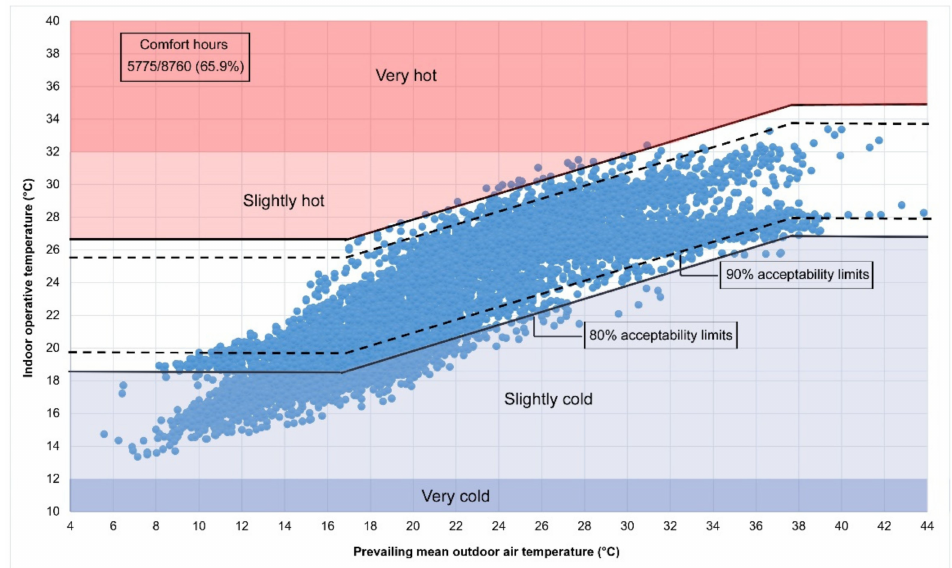
Figure 9. Comfort result and analysis of “optimum case” based on the ASHRAE-55-2020 adaptive comfort model at 90% acceptability